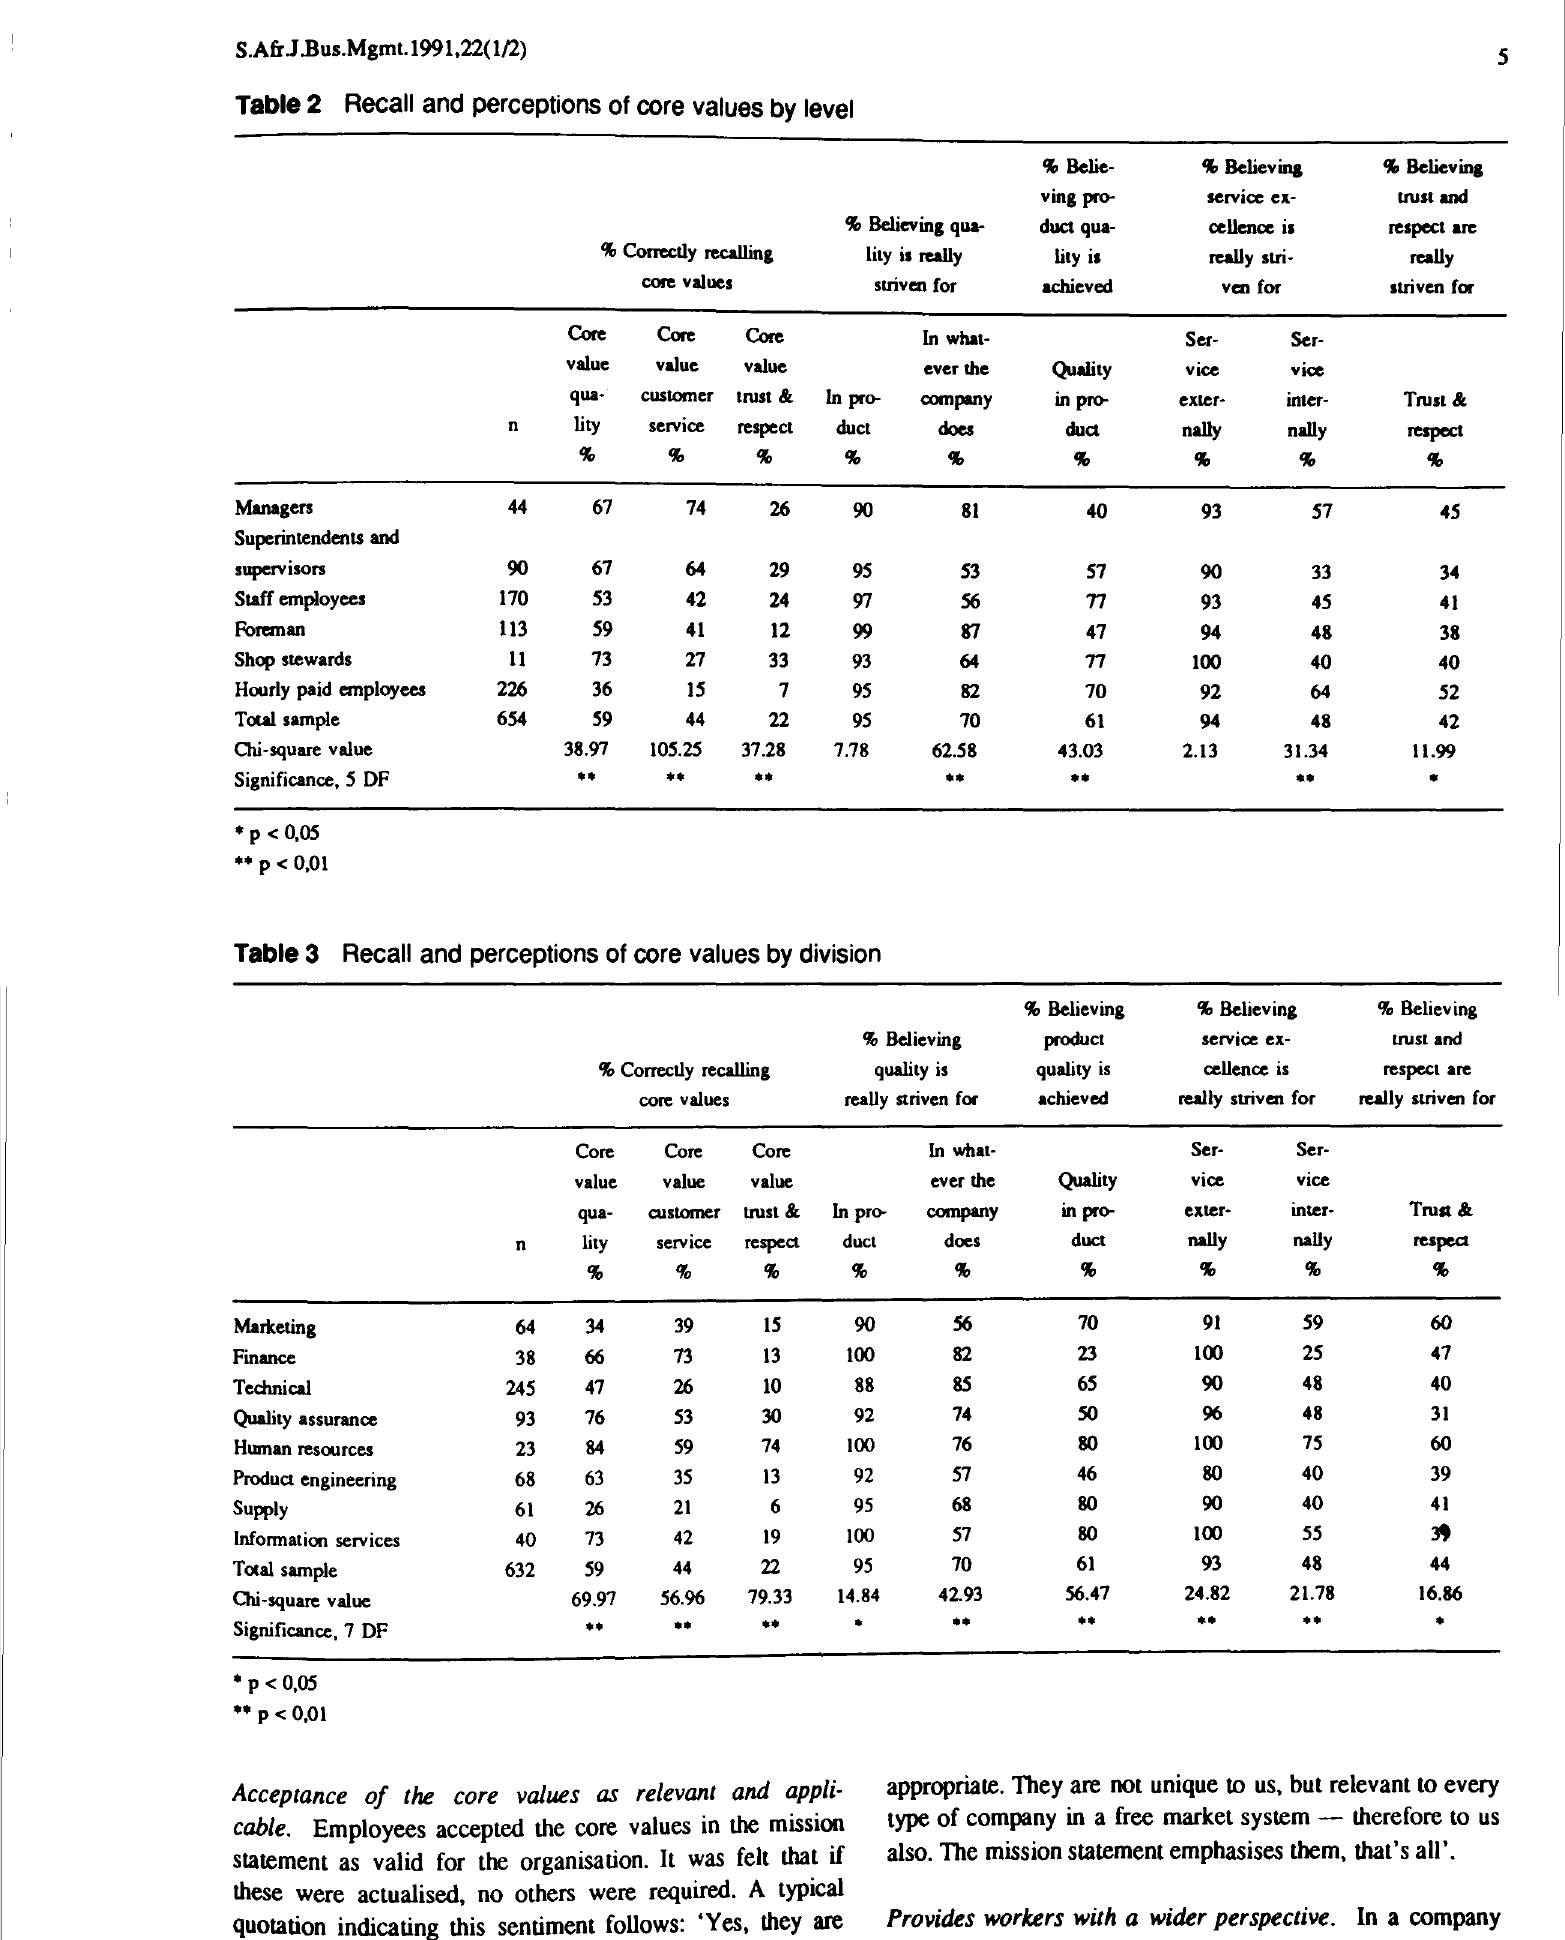
Table2 Recall and perceptions of core values by level